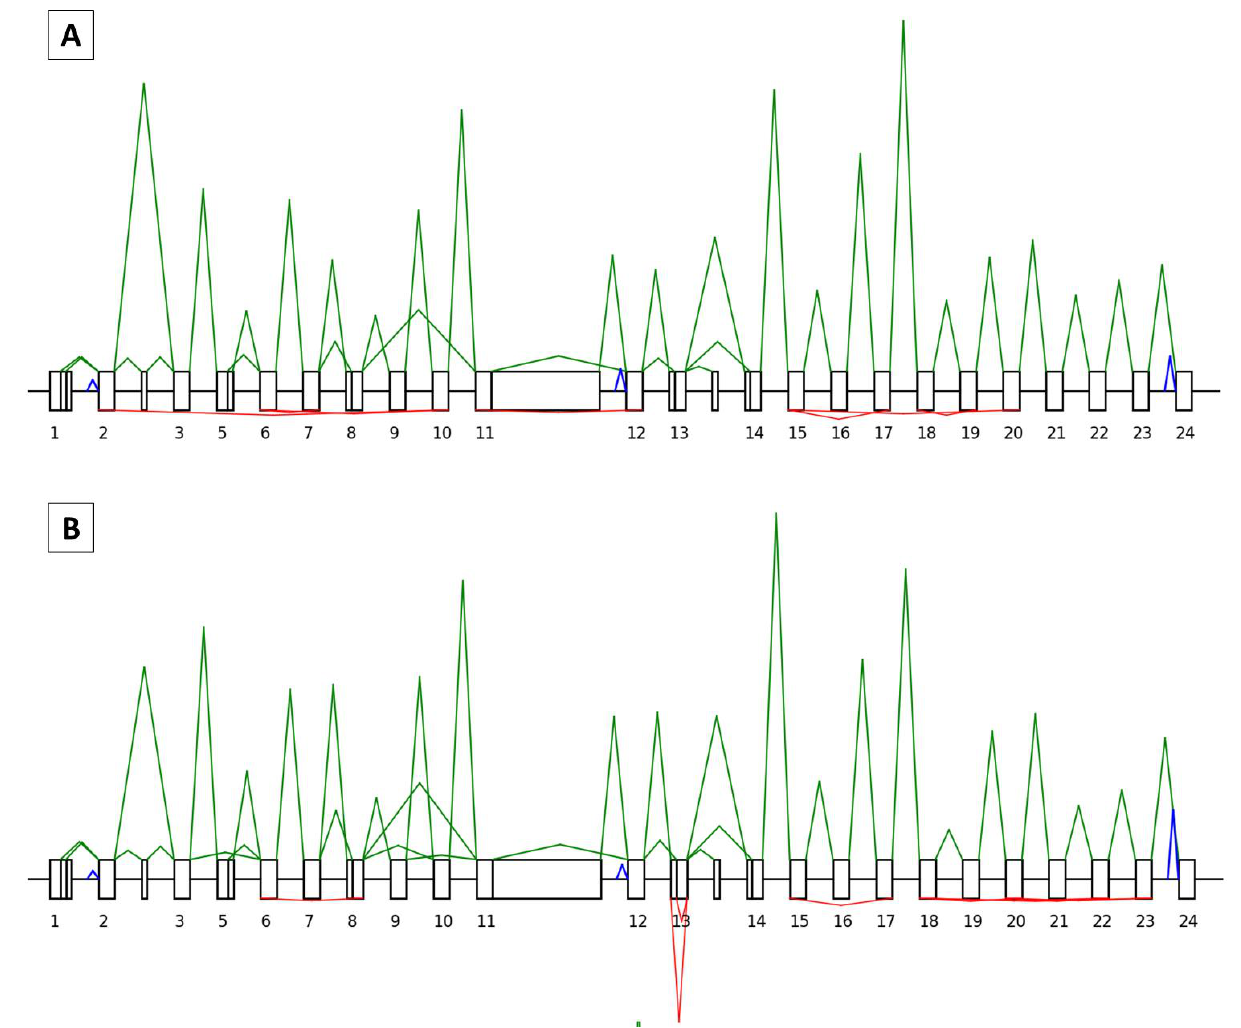
Figure 3. Representation of the BRCA1 splicing and backsplicing profiles. Exons are drawn as boxes and are numbered, with the introns represented as lines. A solid line indicates alternative splice sites within exons. Non-numbered boxes correspond to alternative exons not included in the canonical transcript. Peak heights are relative to the number of UMI counts. For each profile, splicing is indicated in green above the boxes and backsplicing in red below the boxes. The blue peaks correspond to the signals of the intronic probes. ( A ) Control profile (patient 20X0160, normal breast tissue): the BRCA1 canonical transcript with different isoforms (delta 5q, delta 8p, delta 9–10, delta 11q, delta 13p, delta 14q) is shown. In red, below, is the backsplicing from exons 17 to 15 (circRNA_17-15), 19 to 18 (circRNA_19-18), 20 to 15 (circRNA_20-15), 7 to 6 (circRNA_7-6), 10 to 2 (circRNA_10-2), and 10 to 6 (circRNA_10-6). ( B ) Tandem duplication of exon 13 (patient 20X0146, tumor breast tissue) is detected thanks to the two pseudo circular RNAs of exon 13 (both the canonical and alternative 13p transcripts are